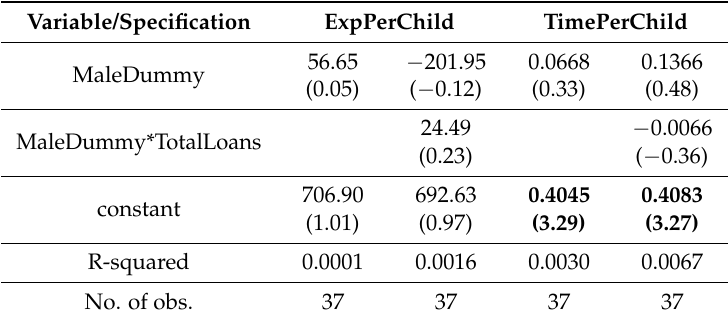
Table 5. Educational Investment and Gender of